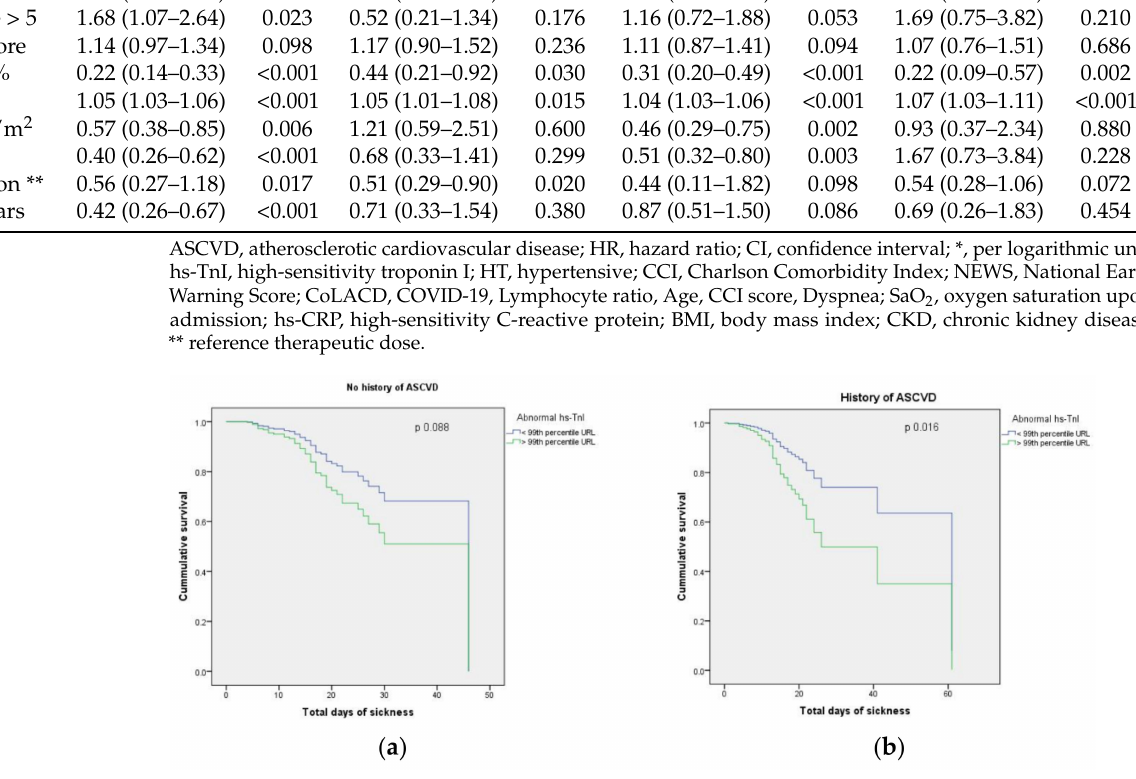
Figure 3. Kaplan–Meier survival curves regarding all-cause mortality according to the admission abnormal high-sensitivity troponin I (hs-TnI): ( a ) In patients without history of Atherosclerotic Cardiovascular Disease (ASCVD); ( b ) In patients with history of ASCVD; URL, upper reference limit. Even after adjustment for D-dimer, hs-TnI remained independently associated with the main composite outcome [HR 1.63 (1.14–2.33), p =0.008] in patients with a history of